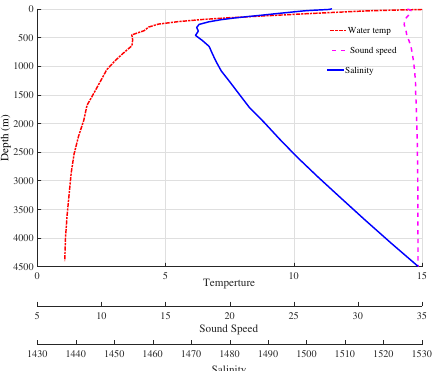
Figure 7. Distributions of sound speed profile (blue solid line), temperature (red dash-dotted line) and salinity (pink dashed line) for the depth from the ocean surface to bottom at the position of CTD.